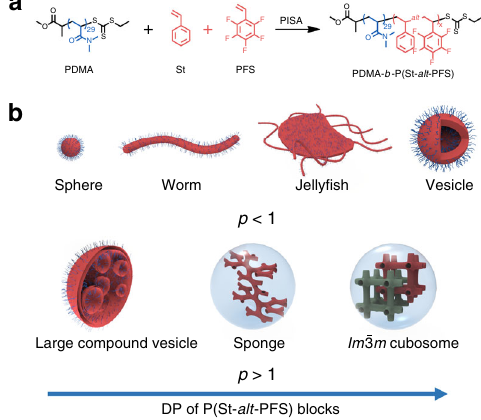
Fig. 1 Preparation of PDMA- b -P(St- alt -PFS) block copolymer (BCP) particles with inverse mesophases via polymerization-induced self- assembly (PISA). a Synthetic scheme of PDMA- b -P(St- alt -PFS) alternating block copolymers. b Schematic illustration of morphological evolution of PDMA- b -P(St- alt -PFS) particles with increasing degree of polymerization of the P(St- alt -PFS) block (the lattice diagrams show bicontinuous internal structures of the nano-objects investigated in this study. For clarity, the bilayers that surround the solvent channels are drawn. The green- and red- colored regions indicate two non-intersecting networks of solvent channels within the bicontinuous structures). PDMA poly( N,N -dimethylacrylamide), St styrene, PFS penta fl